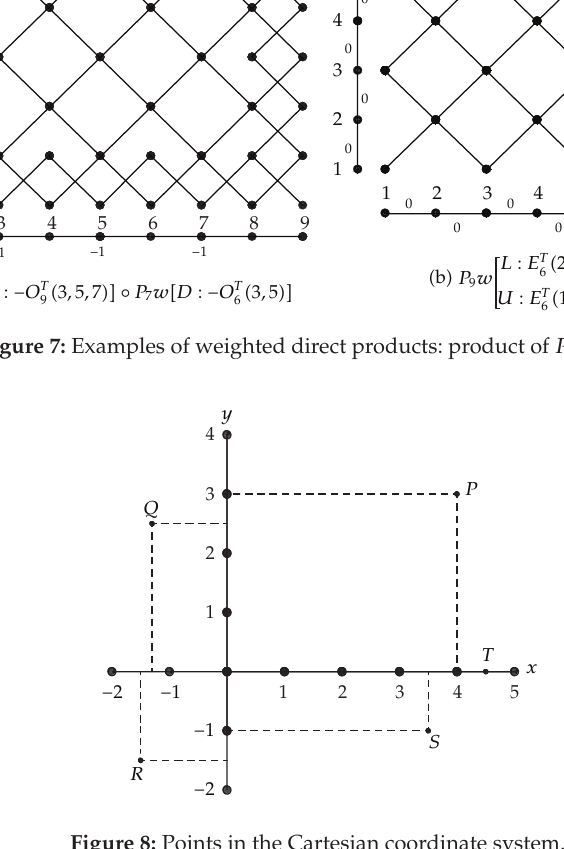
Figure 8: Points in the Cartesian coordinate system.